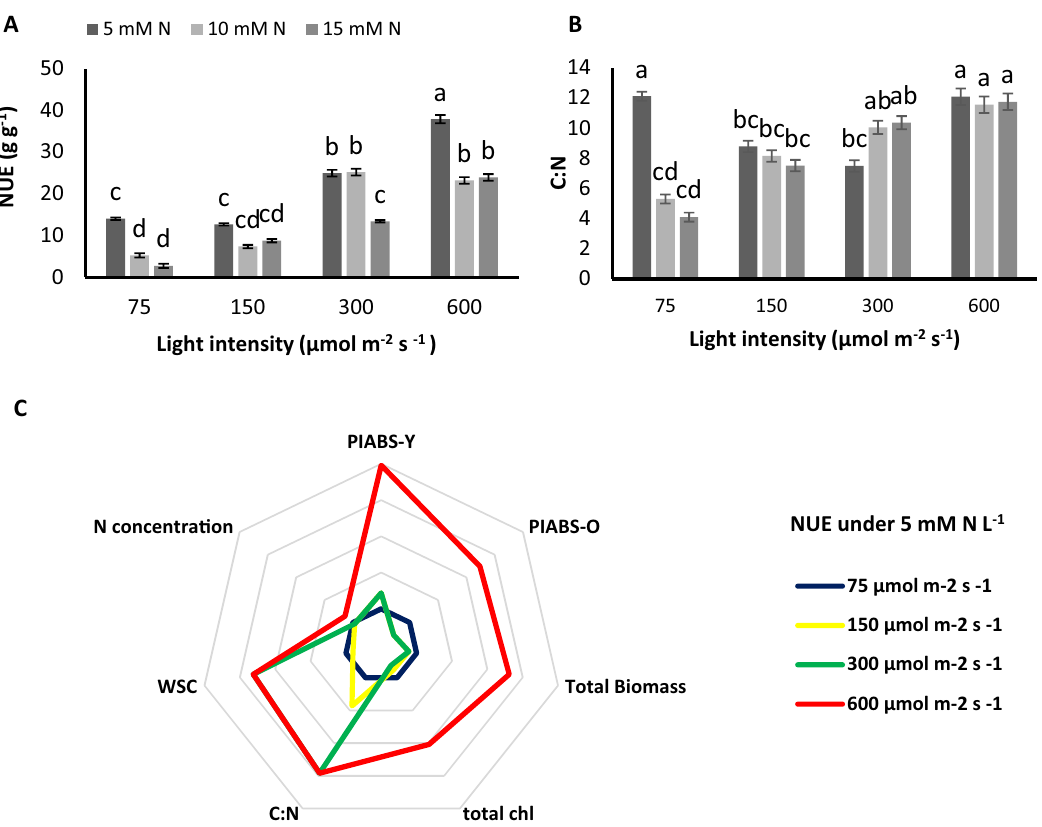
Figure 8. NUE of leaves ( A ) C:N ratio ( B ), of chrysanthemum plants grown under different light intensits (75, 150, 300, and 600 µmol m −2 s −1 ) and nitrogen (N) concentrations (5, 10, and 15 mM N) at 70 days of cultivation. The correlation between NUE of plants fed by 5 mM N with performance index per absorbed light (PI ABS ), total biomass, total chlorophyll (chl), C:N ration, water soluble carbohydrates (WSC), and nitrogen concentration under differenty light intensities (150, 300, and 600 µmol m −2 s −1 ) compared to that of plants under 75 µmol m −2 s −1 ( C ). Vertical bars are means ± SD. Within each graph, interactive effects of light intensity and nitrogen concentration are shown. Different letters (a–d) denote a significant difference between treaments (P <